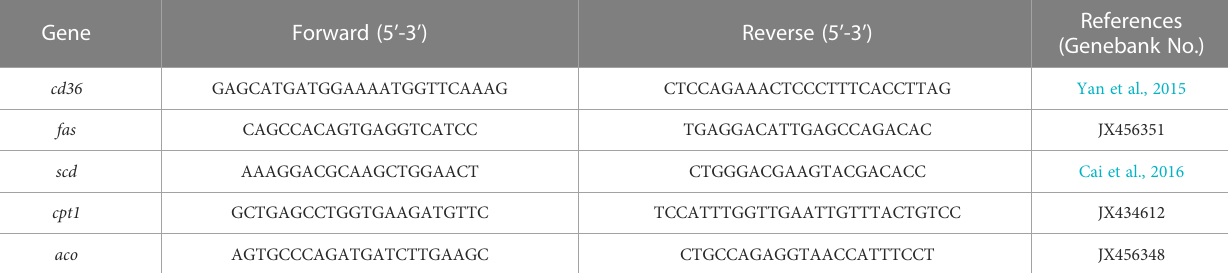
TABLE 2 Gene primers sequence used for real-time